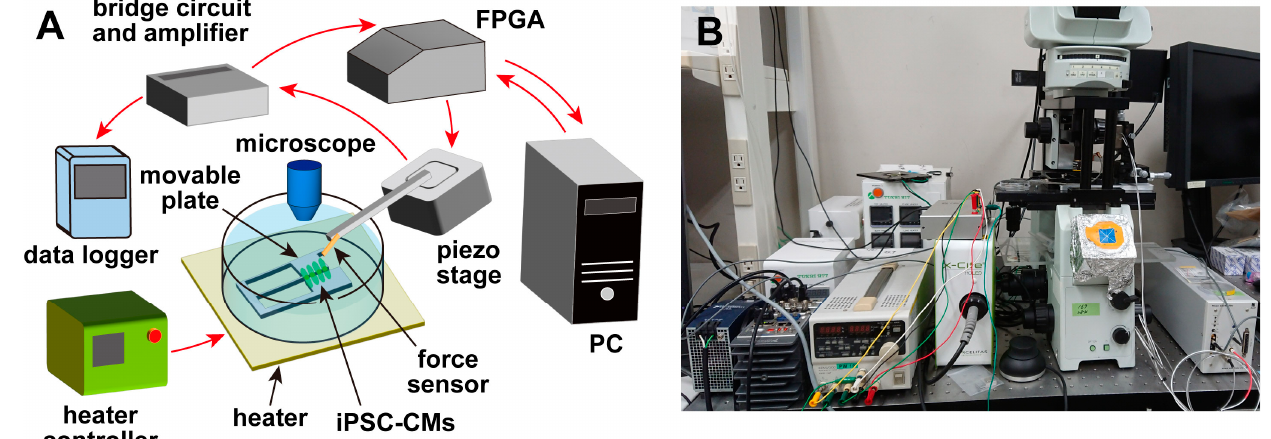
Figure 1. The experimental setup for the pulsation measurements. ( A ) hiPSC-CMs are seeded on a movable plate fixed on the bottom of a petri dish and incubated until they beat; then, they are measured. The displacement sensor can be moved by the piezoelectric stage. The sensor signal is converted to a voltage signal with the bridge circuit, AD-converted in the data logger, and recorded as digital data. ( B ) A photograph of the experimental setup.